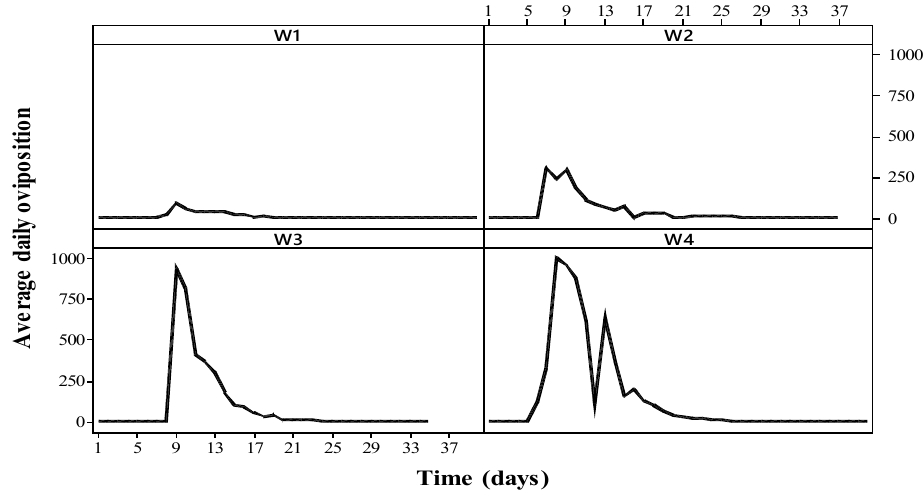
Figure 2: Oviposition patterns of H. isaaci females under four weight categories (W1, W2, W3 and